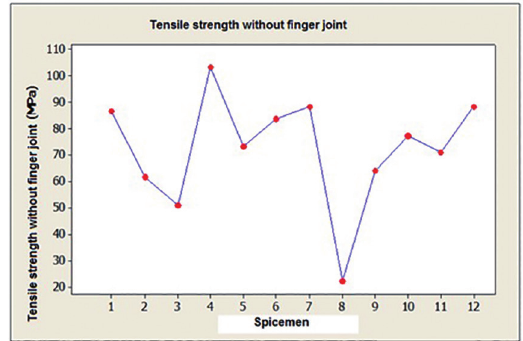
Figure 8: Chart showing tensile strength values for samples without finger